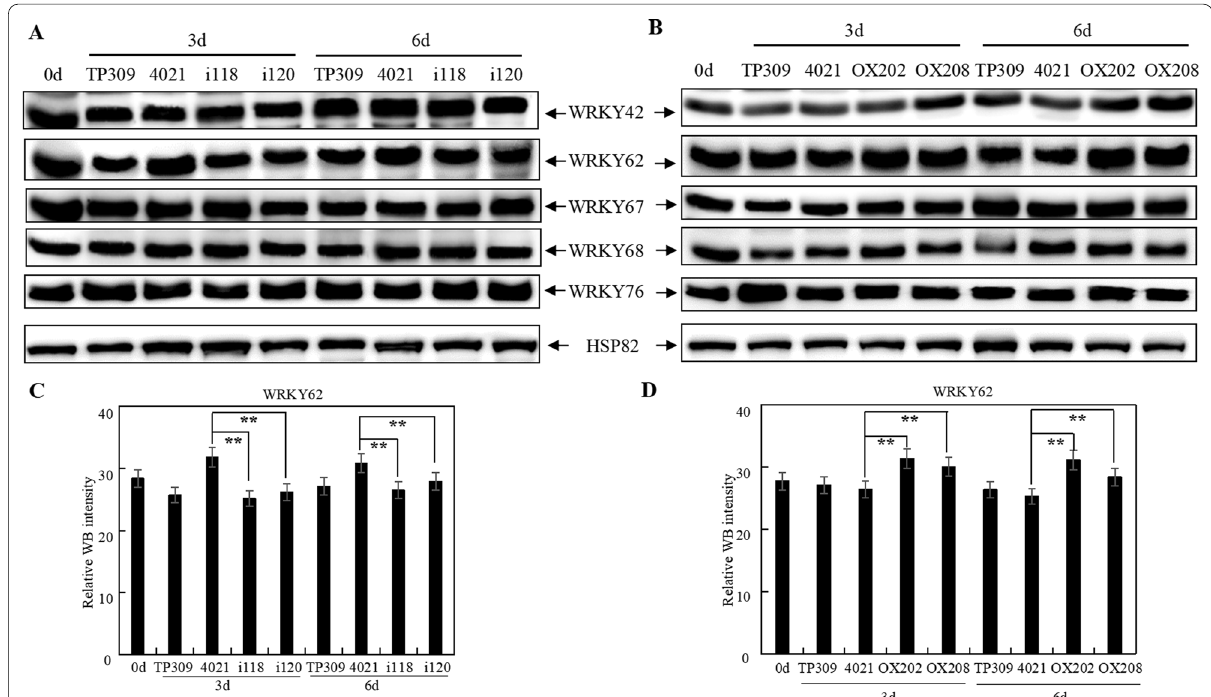
Fig. 9 Expression of WRKY in MPK17-regulated transgenic rice after inoculated with Xoo . A Expression of five WRKY proteins in MPK17-RNAi transgenic rice after inoculated with Xoo . B Expression of five WRKY proteins in MPK17-OX transgenic rice after inoculated with Xoo . C Quantitative comparison of WB intensities of WRKY62 protein in panel ( A ). D Quantitative comparison of WB intensities of WRKY62 protein in panel ( B ). WRKY42: anti- WRKY42 antibody-detected band; WRKY62: anti- WRKY62 antibody-detected band; WRKY67: anti- WRKY67 antibody-detected band; WRKY68: anti- WRKY68 antibody-detected band; WRKY76: anti- WRKY76 antibody-detected band; HSP82: anti- HSP82 antibody-detected band used as loading control. i118, i120: independent MPK17-RNAi transgenic lines; OX202, OX208: independent MPK17-OX transgenic lines; TP309: Japonica rice variety; 4021: transgenic TP309 line harboring the Xa21 gene. Signal of WRKY62 protein in panel A and B were detected by Mini Chemiluminescent Imager and Sage Capture software. Lane 1D software was used to extract signals of WB. Average was calculated for three repeats. Error bars are standard deviation (SD). **designate difference at p < 0.01